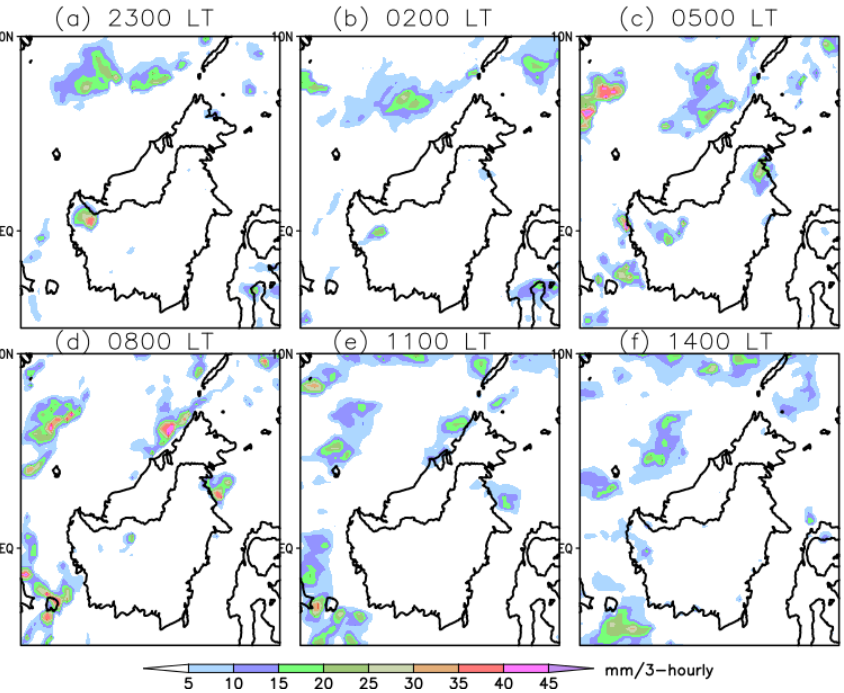
Figure 2. The formation and propagation of a BSL from 26 June 2016 (2300 LT) until 27 June 2016 (1400 LT). ( a ) It shows a typical squall beginning as an initial thunderstorm over the coastal area of Borneo, ( b ) they expand and begin to merge, forming an organized line of thunderstorms, ( c ) following the westerly winds, this line of thunderstorms propagates eastward towards the coastline of Borneo, ( d ) BSL has intensified and reached its maximum intensity on 27 June 2016 (0800 LT) upon arrival at the shoreline, ( e ) BSL clouds are gradually dissipating as their cloud bands dissolve and their intensity weakens from 27 June 2016 (1100 LT), ( f ) as observed on the next 3-h observation 27 June 2016 (1400 LT), the BSL clouds are no longer visible, signaling the dissipation of BSL.